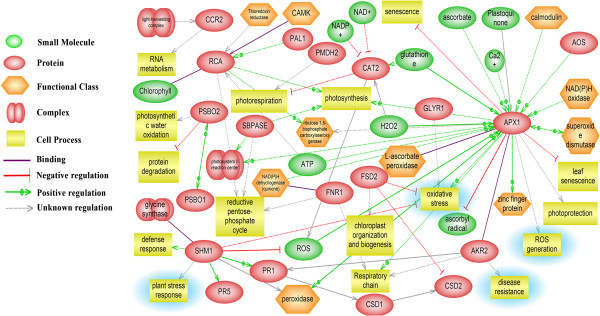
Biological network of differentially abundant protein homologues constructed using the Pathway Studio software (version 7.1). Proposed interactions are indicated by dashed lines (-----) and evidence-based interactions are indicated with solid lines (—). Abbreviations of the identified nodal proteins are CCR2: glycine rich RNA binding protein; RCA: rubisco activase; PSBO1/2: photosystem II oxygen evolving enhancer protein; SHM1: serine/glycine hydroxymethyltransferase; FNR1: ferredoxin: NADP(H) oxidoreductase; SBPASE: sedoheptulose-1,7-bisphosphatase; AKR2: ankyrin repeat protein; CSD1: copper/zinc superoxide dismutase; FSD2: Fe-superoxide dismutase; GLYR1: gamma-hydroxybutyrate dehydrogenase, APX1: ascorbate peroxidase.